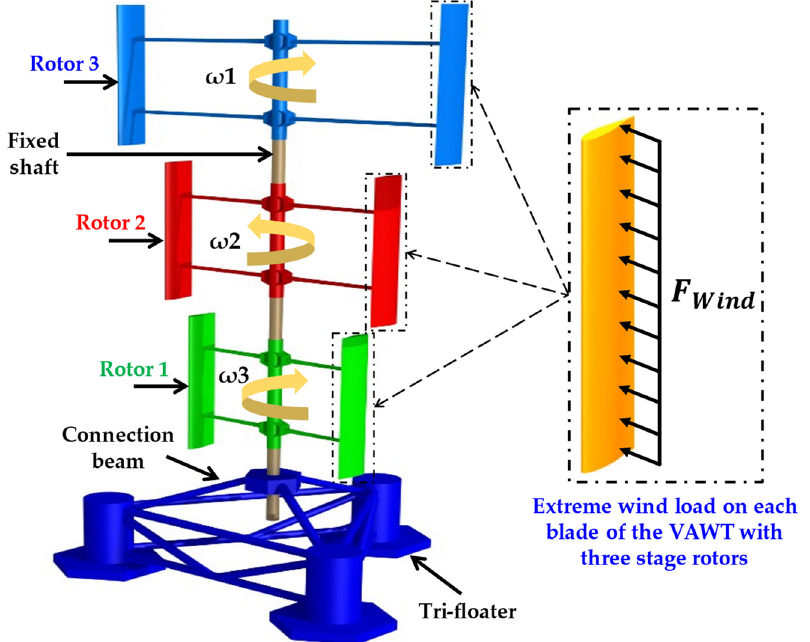
Figure 1. Three-dimensional design of a Darrieus-type floating wind turbine with three-stage rotors under extreme wind load on each blade.